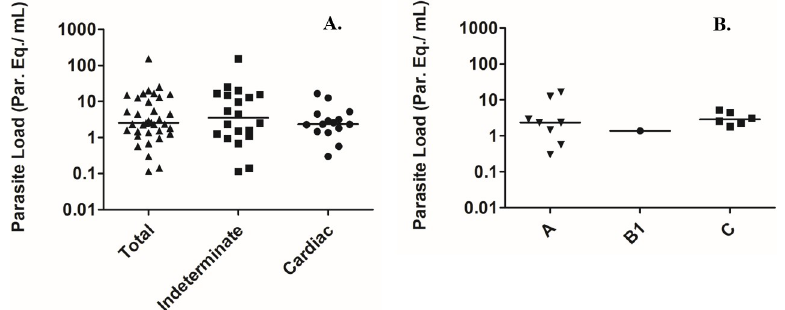
Fig 1. Parasite load in chronic patients with different clinical manifestations of Chagas disease. In A, total parasite load ( ▲ ) and according the type of clinical manifestation: indeterminate ( ■ ) or chronic Chagas heart disease ( ● ). In B, parasite load according the severity of the cardiomyopathy: A ( ▼ ), B1 ( ● ) and C ( ■ ). The horizontal lines represent the median values of the parasite load.